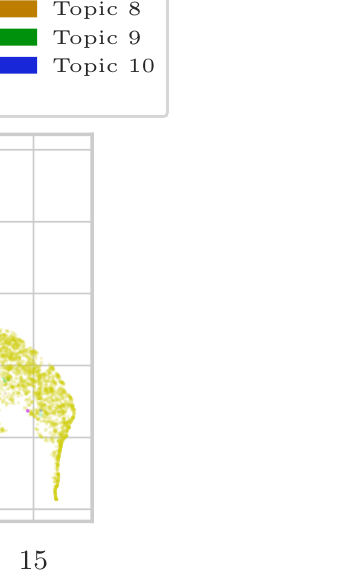
Figure A15. 2-dimensional representation of word embeddings A (cid:48) colored by topic